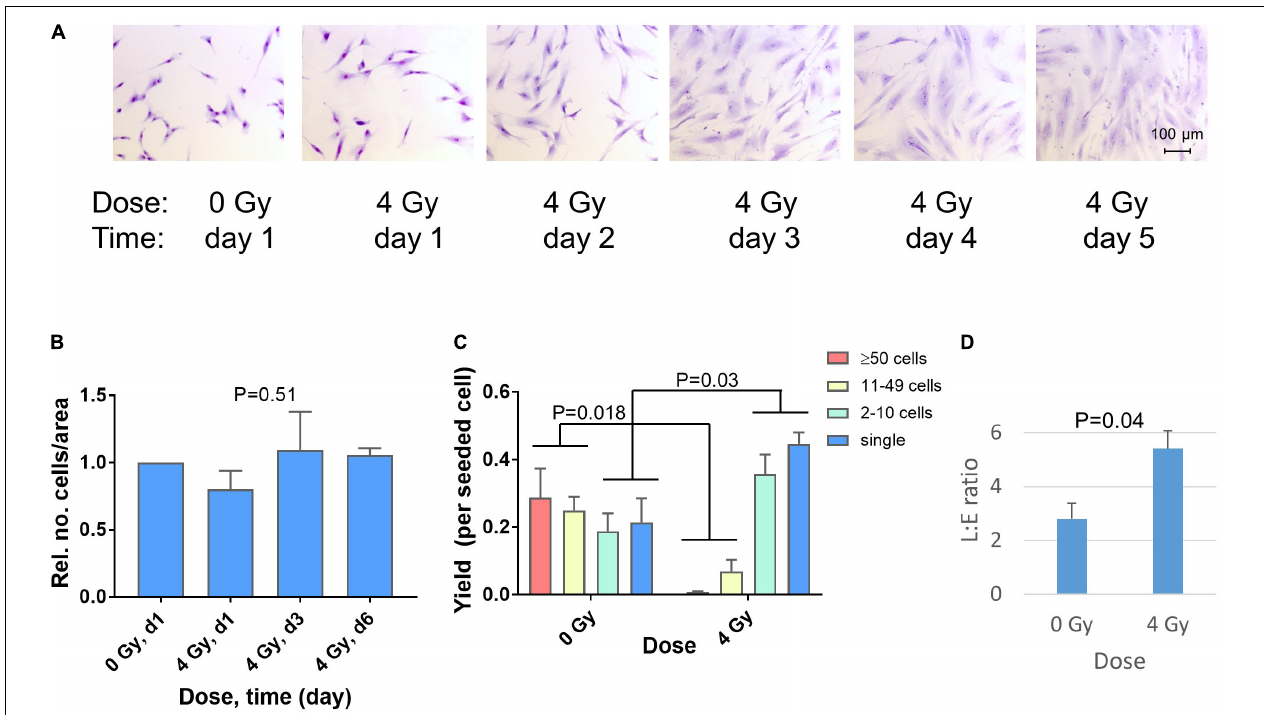
FIGURE 1 | Changes in cell morphology 1–5 days after irradiation of GS4 in microscope chamber slides with a dose of 4 Gy (A) . Relative numbers of cells on day 1, 3, and 6 after irradiation of GS3, GS4, and GS5 in six-well plates with 4 Gy. For each fibroblast strain, the total number of cells in all six wells of the plate was scored. P = 0.51 (ANOVA, N = 12, n = 3 per group) (B) . The yield of clones per seeded cell in the colony formation assay (T75 flasks) with GS3, GS4, and GS5, irradiated at low cell density after doses of 0 Gy (sham) and 4 Gy. Cytomorphological assay (clonal culture at low cell density), clones sizes: ≥ 50 cells (colonies), 11–49 cells